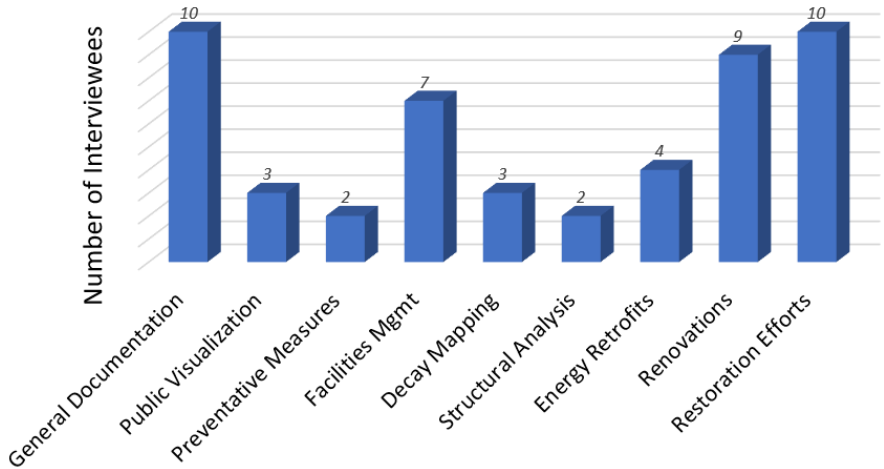
Figure 14. Results to interview question #4: data management techniques.